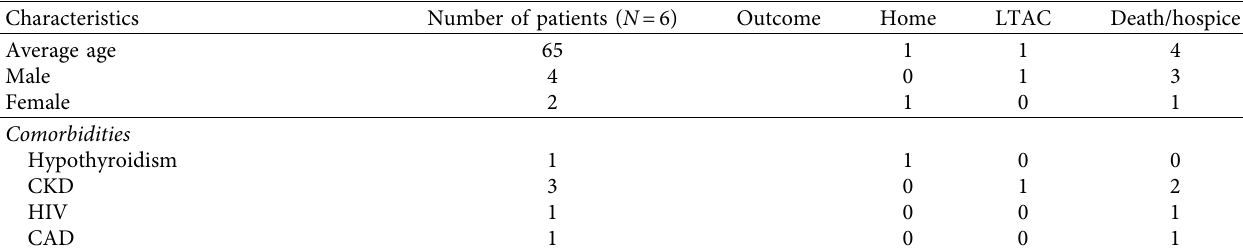
Table 3: Characteristics of patients with ARDS and outcome of patients who were not treated with doranase alfa.